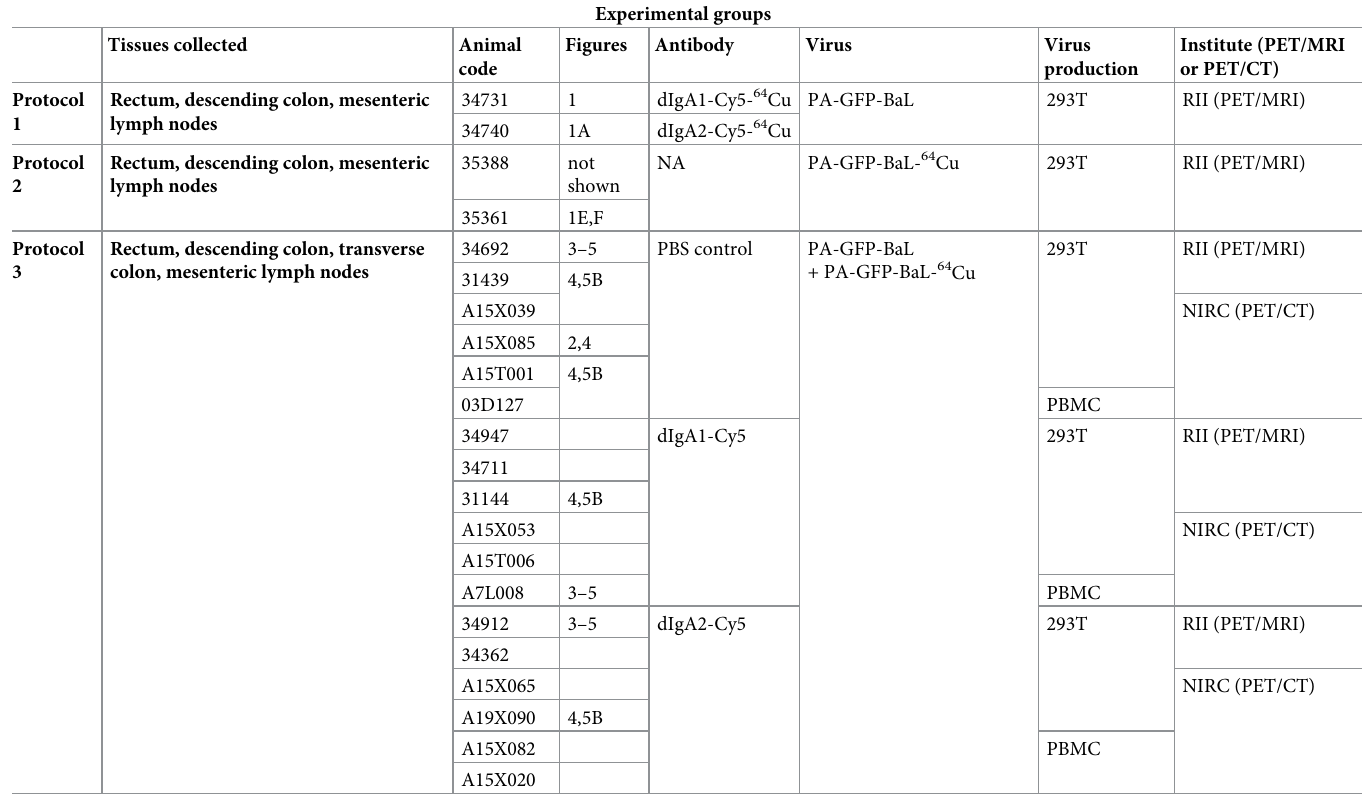
Table 1. Identification of rhesus macaques used in each experimental protocol.